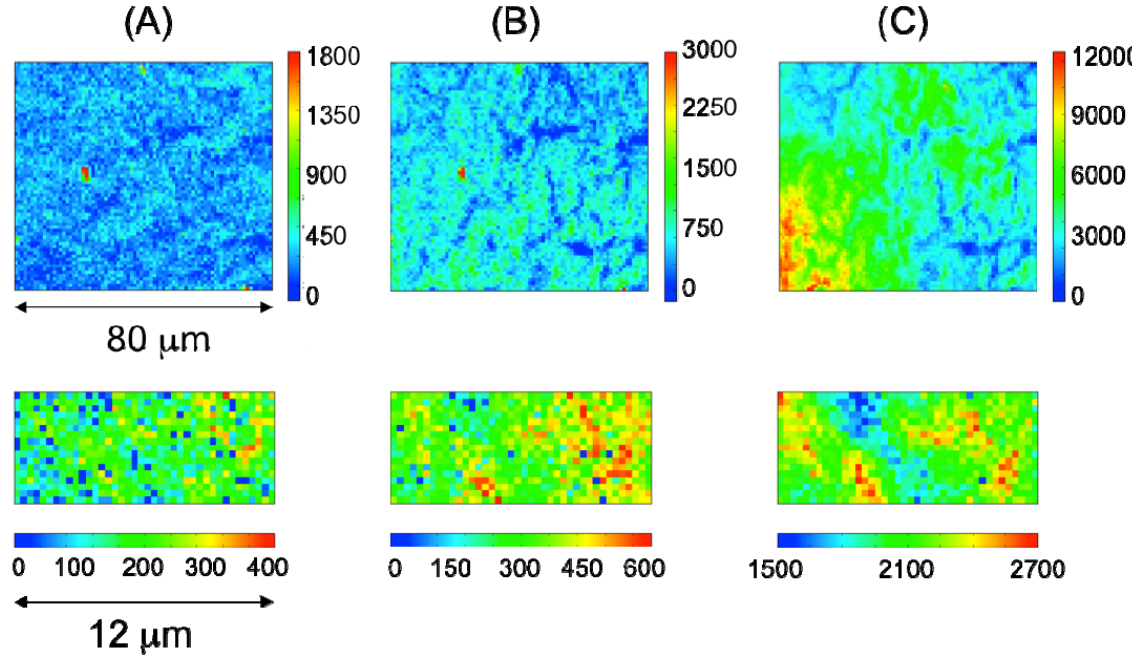
Figure 3. XRF maps of electrodeposited Mn–Co–Cu/PPy composites (energy: 1 keV, step size: top 1 μ m, bottom 0.3 μ m): ( A ) Mn; ( B ) Co; ( C ) Cu.